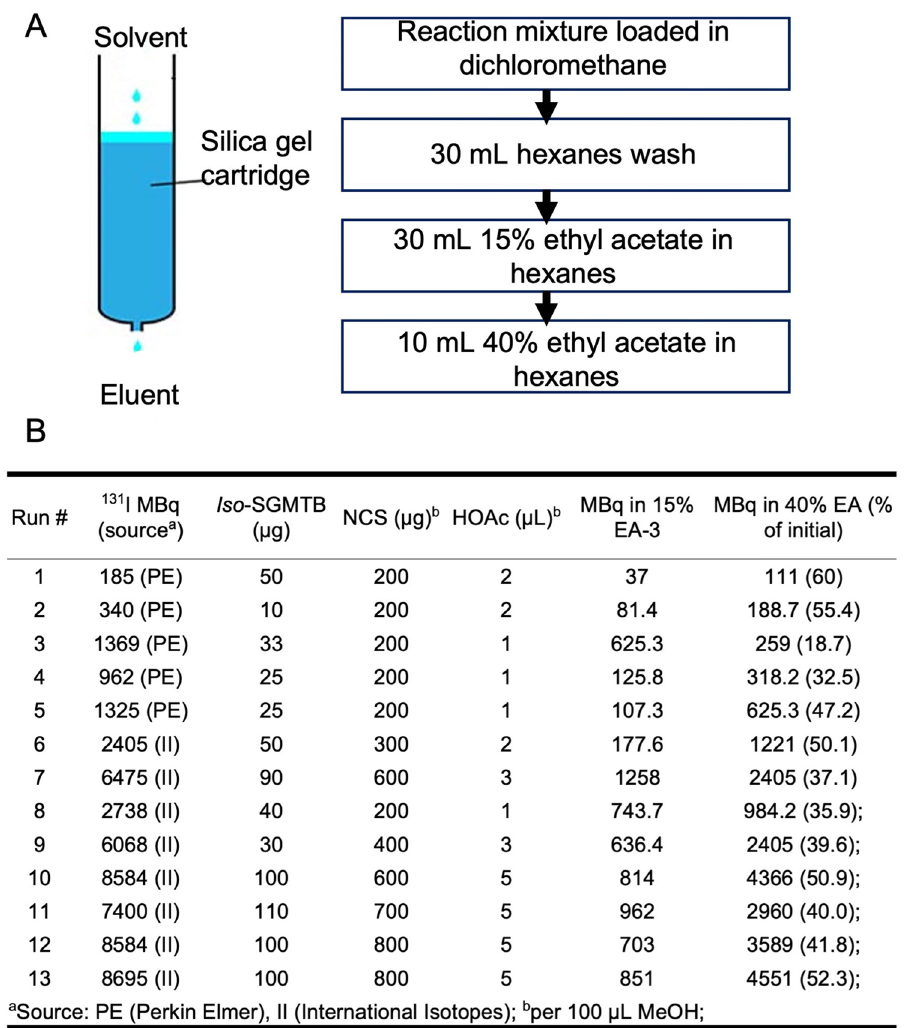
Figure 1. Scale-up production method for iso -[ 131 I]SGMIB. ( A ) Description of the Silica Gel cartridge method for purification. ( B ) Radiolabeling and purification